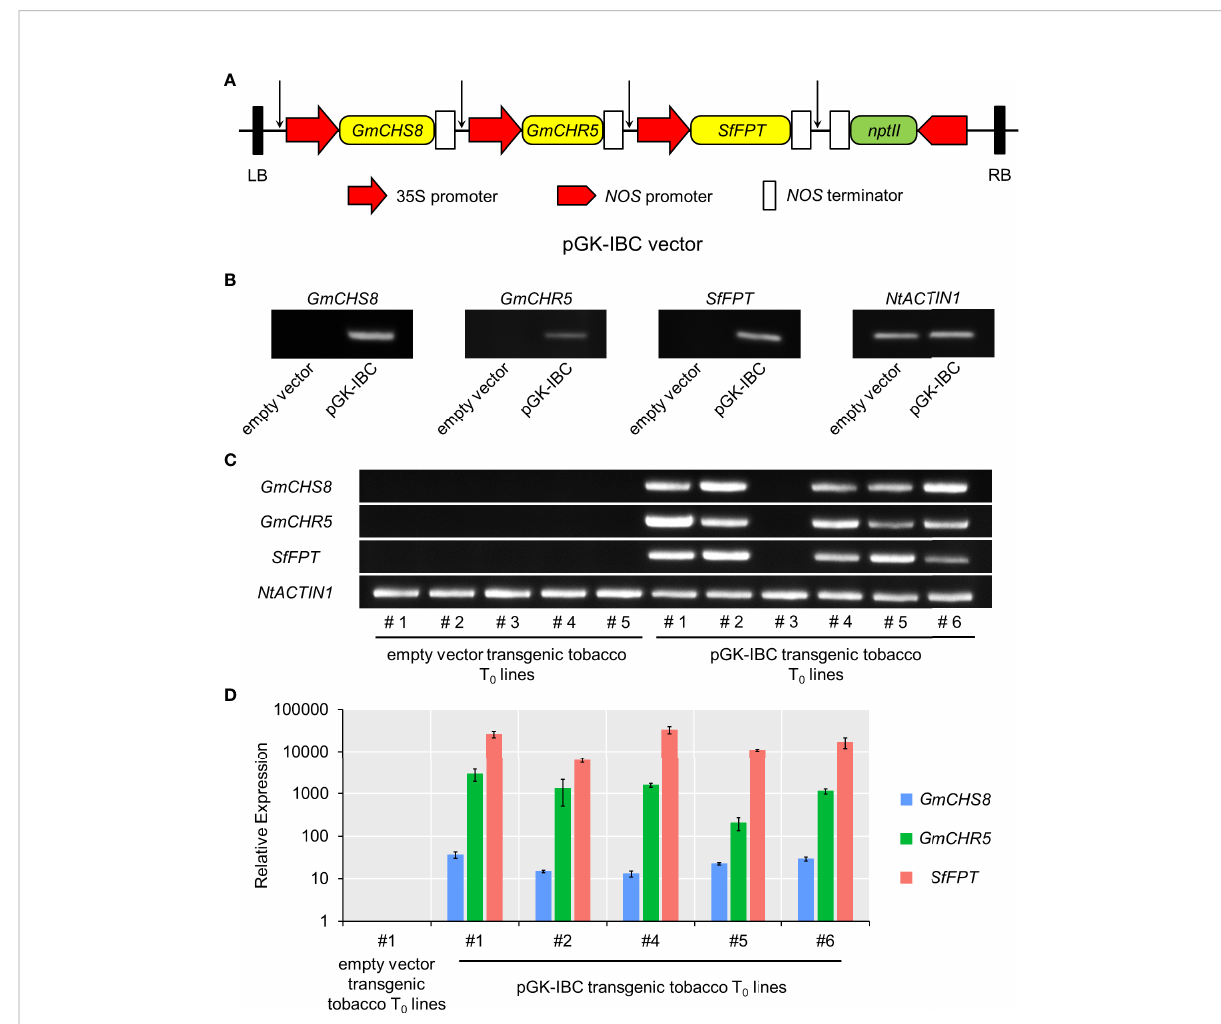
FIGURE 4 Schematic structure of the multigene expression vector and the validation of its gene expression. (A) The region spanning the LB and RB was indicated. Arrows indicated the conjunction sites after Golden Gate assembly. (B) RT-PCR analysis of GmCHS8 , GmCHR5 , and SfFPT in pKG-IBC and empty vectors transiently expressed tobacco leaves. (C) RT-PCR analysis of pGK-IBC and empty vectors transgenic tobacco T 0 lines. The expression of GmCHS8 , GmCHR5 , and SfFPT was con fi rmed. NtACTIN1 was used as a reference gene. (D) Quantitative real-time reverse transcription-PCR analysis of pGK-IBC and empty vectors transgenic tobacco T 0 lines. LB, left border; RB, right border; nptII , neomycin phosphotransferase